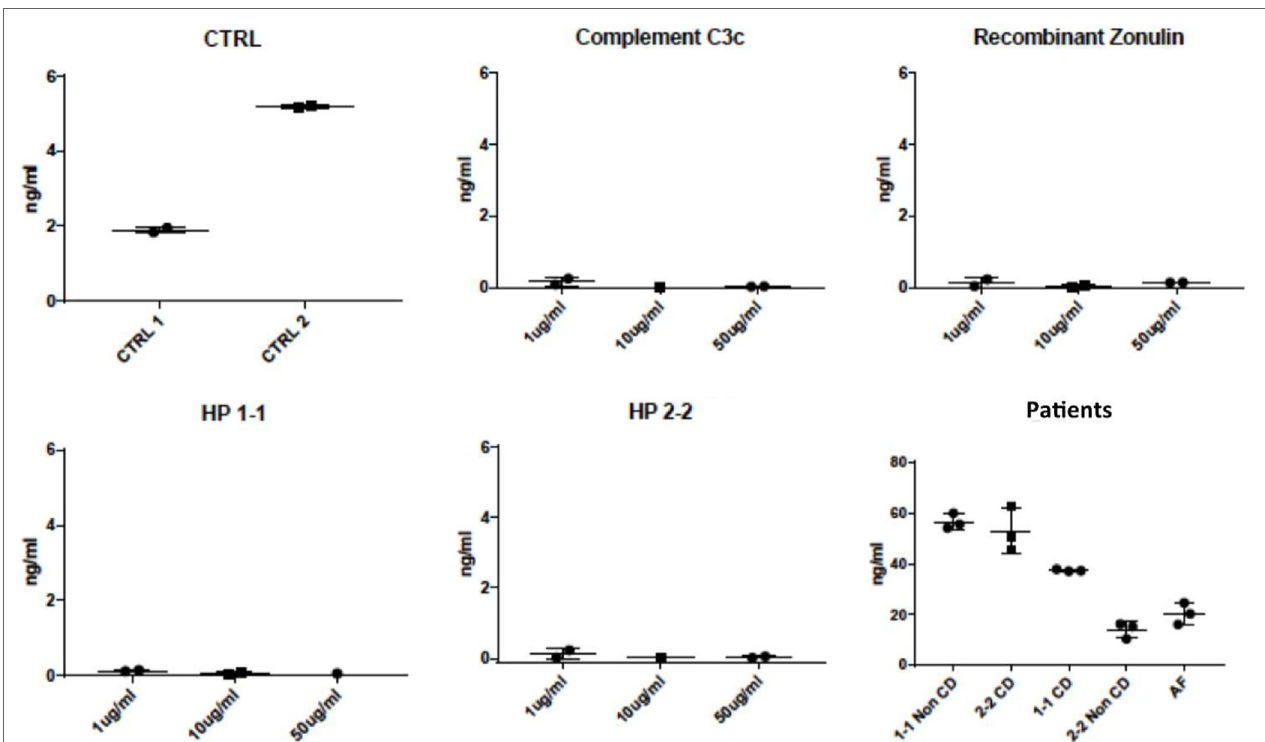
FigUre 3 | Mean zonulin ELISA values obtained by testing specific candidate target proteins and patients’ serum samples. This ELISA kit did not detect increasing concentrations (range 1–50 µg/mL) of complement, recombinant zonulin (pre-HP2), mature HP1 or mature HP2. Conversely, a strong signal was detected in sera of both celiac disease patients (CD) and healthy controls (non-CD, internal control AF with HP2-2), irrespective of their HP genotype. All samples were measured in technical triplicates; kit controls are shown for comparison. FigUre 4 | Western blot analyses of a prototype human serum sample (AF HP2-2) using both anti-zonulin monoclonal antibodies and Immundiagnostik polyclonal antibodies. (a) Prototype serum sample of an HP2-2 homozygous subject, either untreated (lane 1) or after deglycosylation (lane 2) was resolved and then immunoblotted using either anti-zonulin monoclonal antibodies (left panel) or Immundiagnostik polyclonal antibodies (right panel). Recombinant zonulin was added as control (lane 3). As anticipated, zonulin monoclonal antibodies recognize the recombinant protein as well as a serious of serum bands, with the strongest signal being related to the 16-kDa zonulin α 2-chain. The Immundiagnostik polyclonal antibodies also recognize recombinant zonulin but with a much weaker signal compared with the monoclonal antibodies. These antibodies also recognize the same serum bands detected by the zonulin monoclonal antibodies, with the ~70- and 52-kDa bands being highlighted with the strongest signal. Sample’s deglycosylation showed the shift of the 70-kDa band to a lower MW, suggesting that this may represent the zonulin β -chain as we have previously shown (14). (B) Prototype serum samples of an HP1-1 and an HP2-2 homozygous subject were resolved and immunoblotted using the Immundiagnostik polyclonal antibodies. Recombinant zonulin and properdin were added as control. The antibodies also detect properdin that migrated at the same molecular weight of zonulin and serum bands recognized by the antibodies in both HP2-2 and HP1-1 subjects.